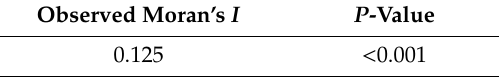
Table 3. Moran’s I test results for residual spatial dependence in the non-spatial model (i.e., ordinary least squares (OLS) model).